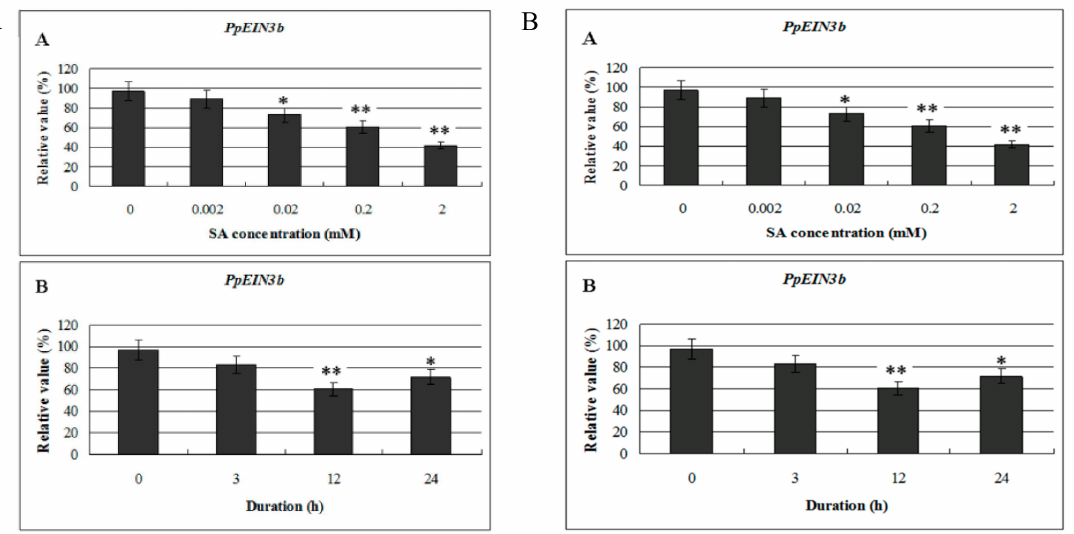
Figure 5. ( A ) qRT-PCR analysis of expression of PpEIN3b in fruit under SA treatment for 12 h. Relative values of expression of PpEIN3b in fruit 150 days after full bloom treated with 0, 0.002, 0.02, 0.2, and 2.0 mM SA for 12 h are shown as percentage of PpUBI expression. ( B ) qRT-PCR analysis of expression of PpEIN3b in fruit under 0.2 mM SA treatment. Relative values of expression of PpEIN3b in fruit 150 days after full bloom treated with 0.2 mM SA for 0, 3, 12, and 24 h are shown as percentage of PpUBI expression. Mean values and standard errors (bar) are shown from three independent experiments. Independent t tests for equality of means demonstrated significant (* p value < 0.05) or very significant (** p value < 0.01) di ff erence between control and treated fruit. SA: salicylic